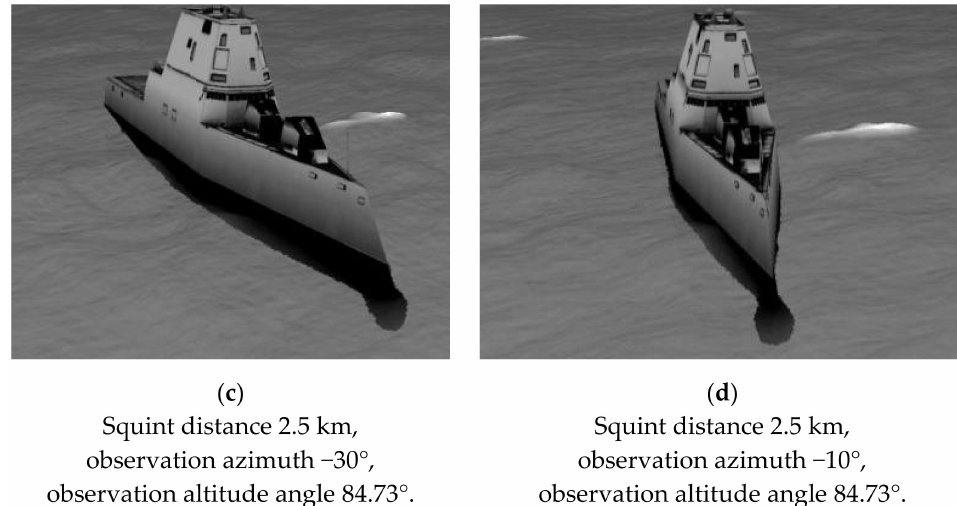
Figure 6. Simulation results of the ship target scene in the visible light band for different squint distances and viewing angles under the conditions of 15 ◦ of solar altitude angle, mid-latitude summer atmospheric model, marine aerosol type, and visibility of 23 km.